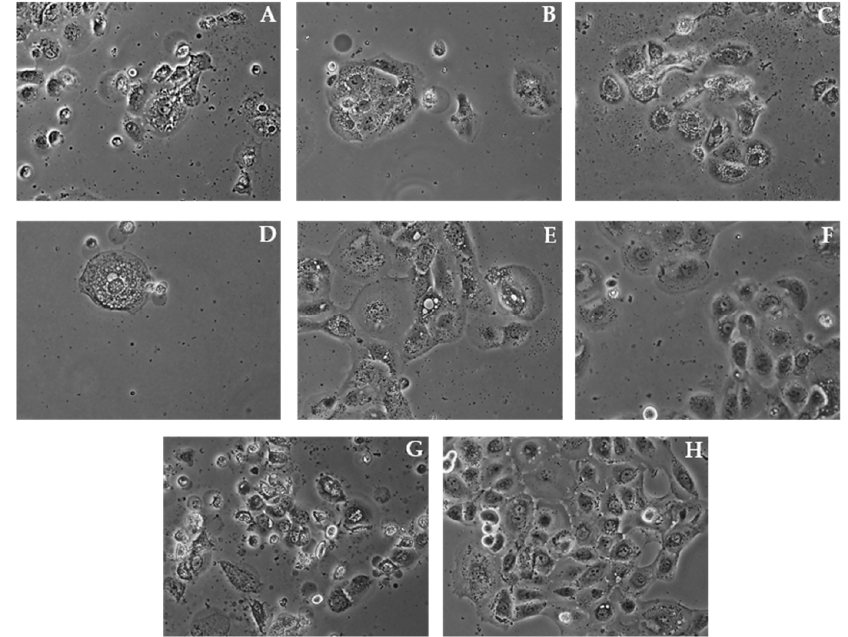
Figure 4. Morphological profile of SCC-25 cells after 24 h of incubation with HP1 ( A ), HP6 ( B ), and HP7 ( C ) at the concentration of 100 µg/mL and with 1 ( D ), 7 ( E ), ZAP ( F ), and cPT ( G ) at 100 µM concentrations compared the untreated control cells ( H ).